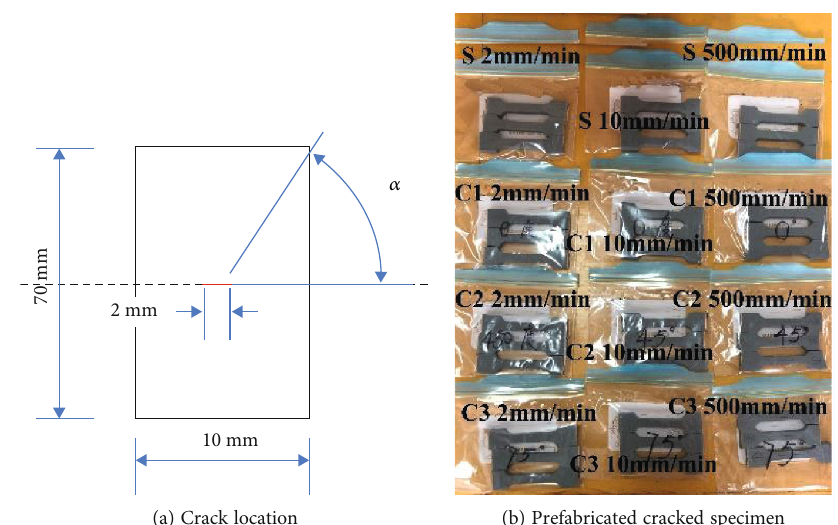
Figure 3: Prefabricated